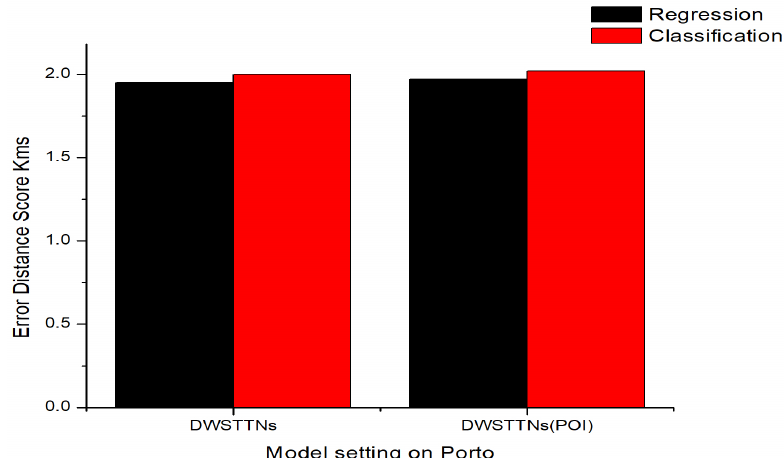
Figure 9. The Regression and classification performance on Porto